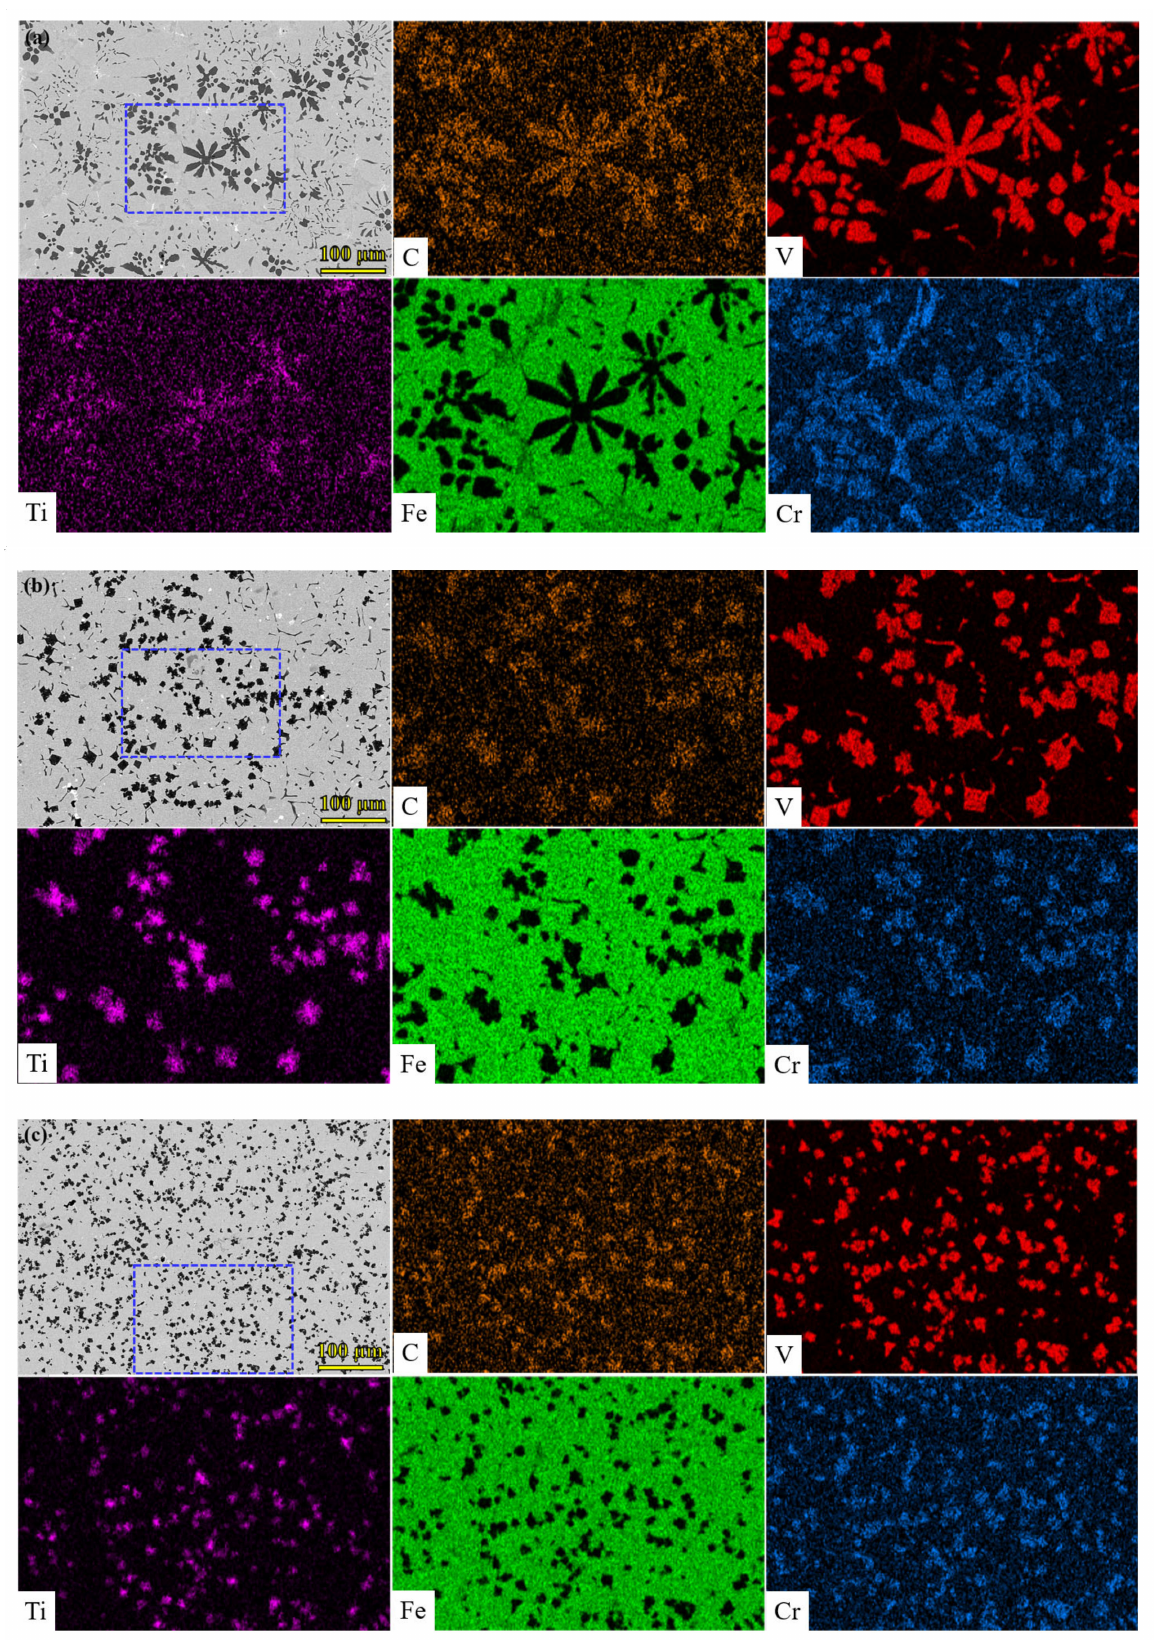
Figure 2. SEM images and EDS mapping of three samples. ( a ) 1.5 Mn; ( b ) 3.0 Mn; and ( c ) 4.5 Mn. The maps of elemental distribution is only presented within the blue